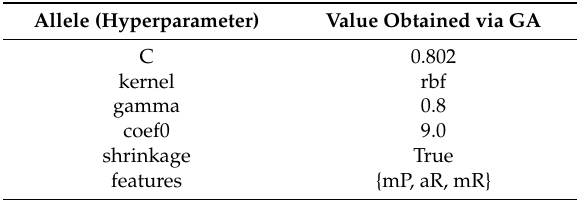
Table 10. Best-evolved values of hyperparameters of